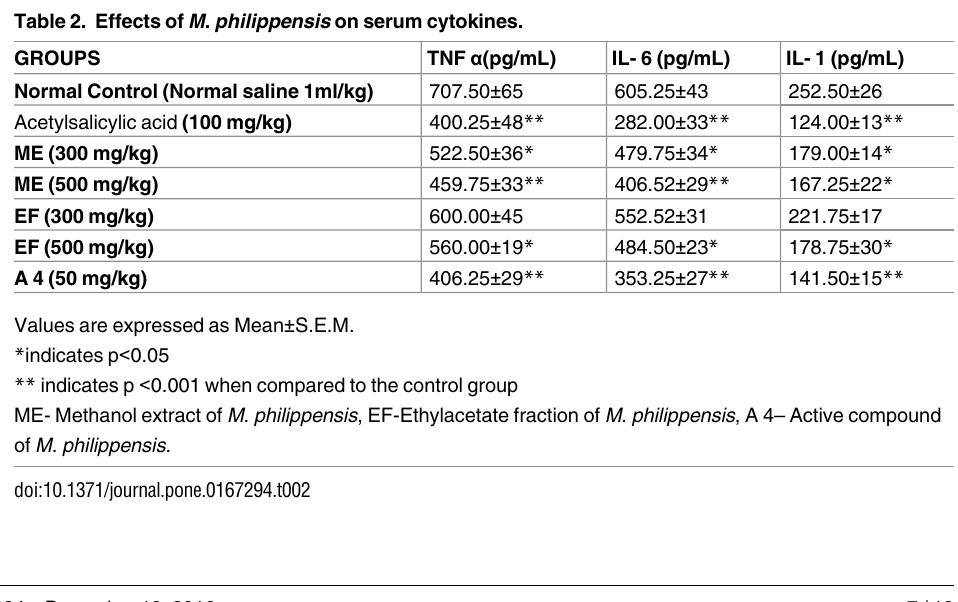
doi:10.1371/journal.pone.0167294.g001